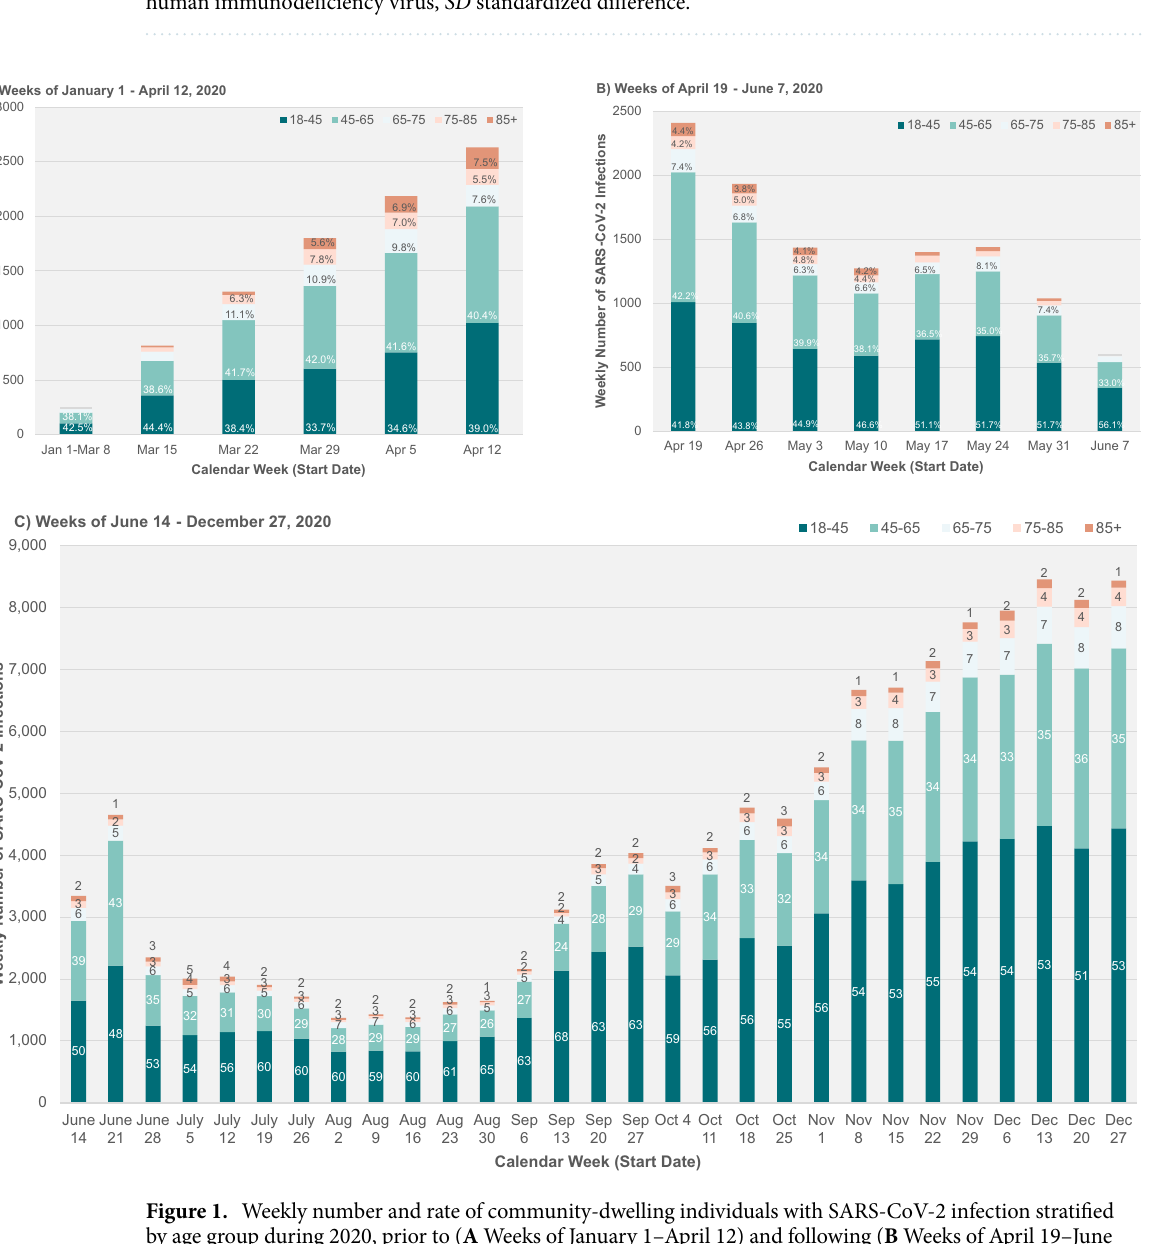
Table 1. Baseline characteristics of community-dwelling patients with and without SARS-CoV-2 infection during the first wave of the pandemic in Ontario, Canada. Continuous variables are reported as median (interquartile range). In the early stages of modelling, there was significant heterogeneity between age and week of testing ( P -interaction < 0.0001), hence results are presented stratified prior to and following the peak of the first wave of the pandemic until the end of 2020 (Supplementary Table 2). ED emergency department, HIV human immunodeficiency virus, SD standardized difference.